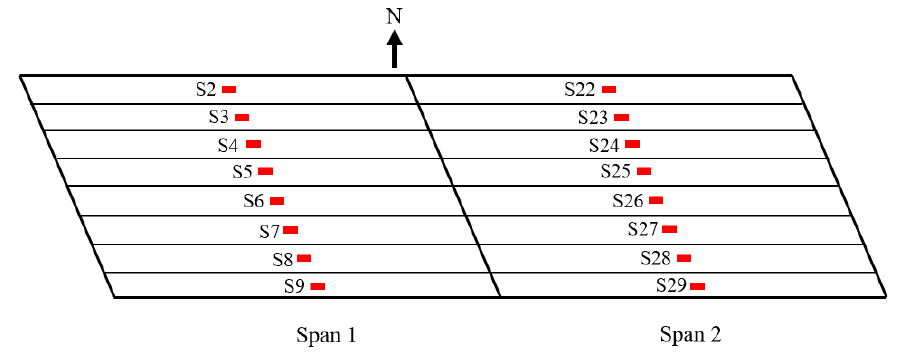
Figure 5. Location of the installed sensors.